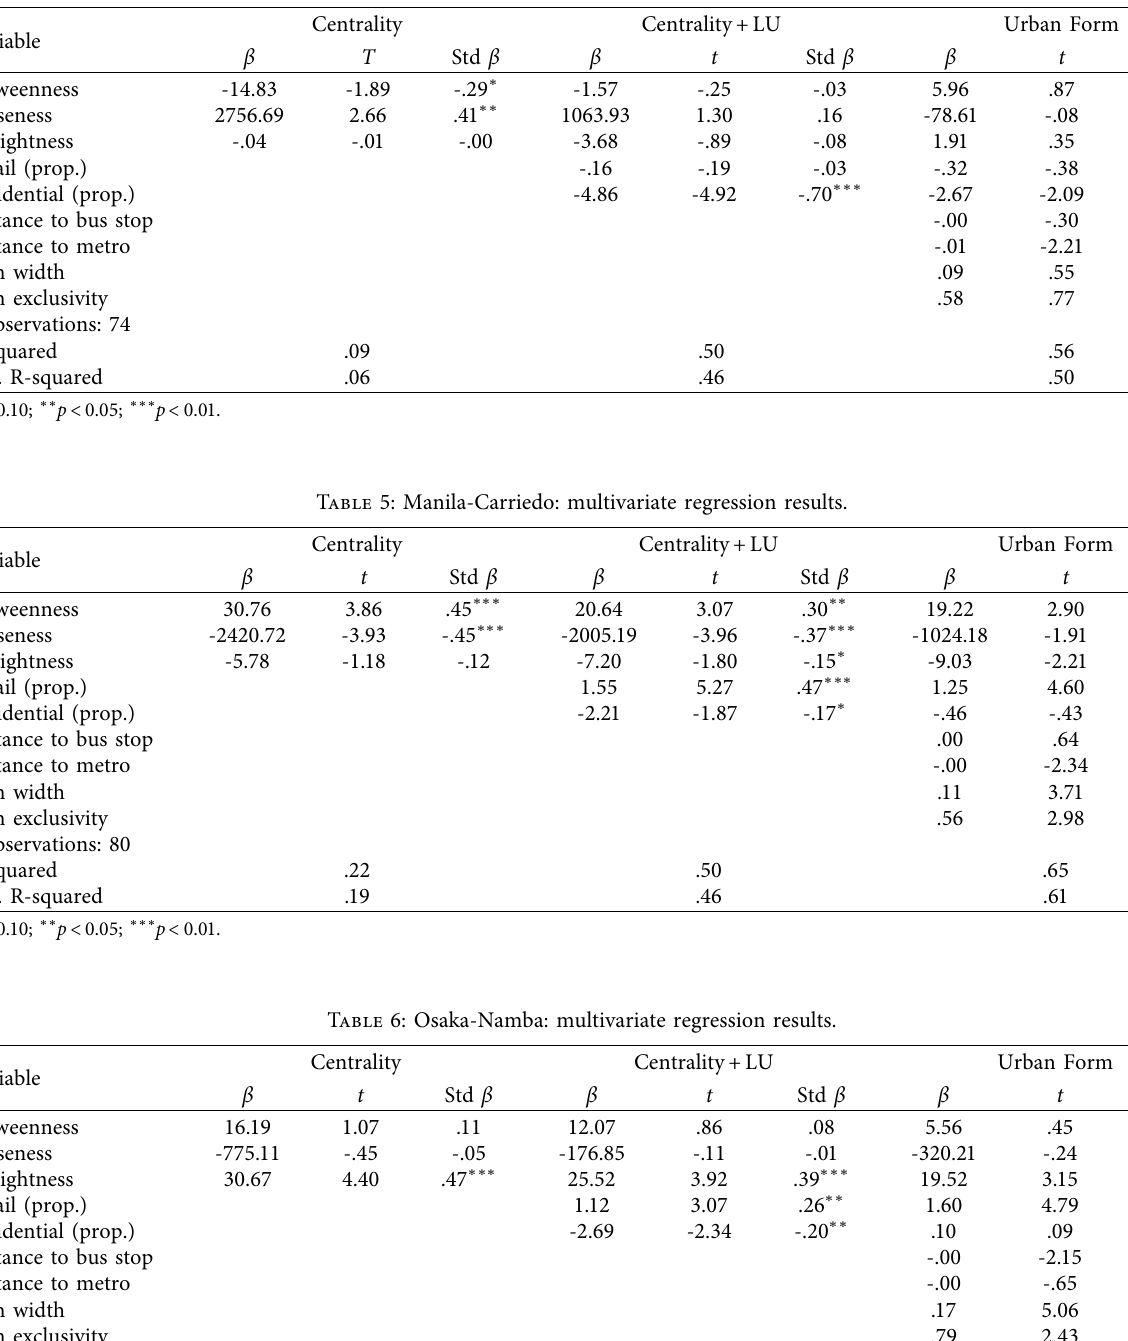
Table 4: Bangkok-Sukhumvit: multivariate regression